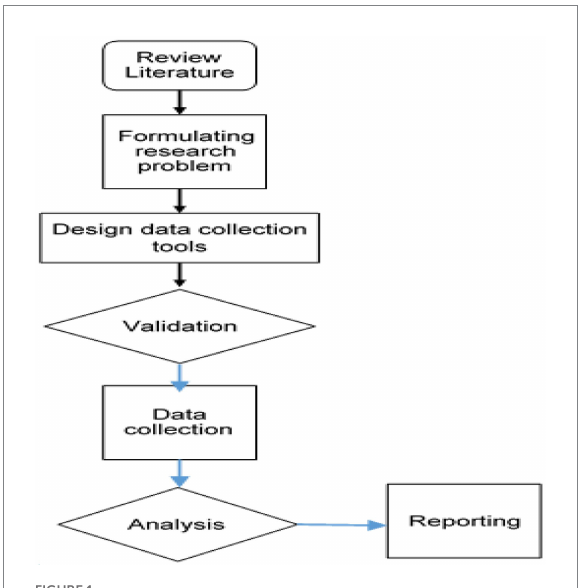
FIGURE 1 A graphical representation of the research design and